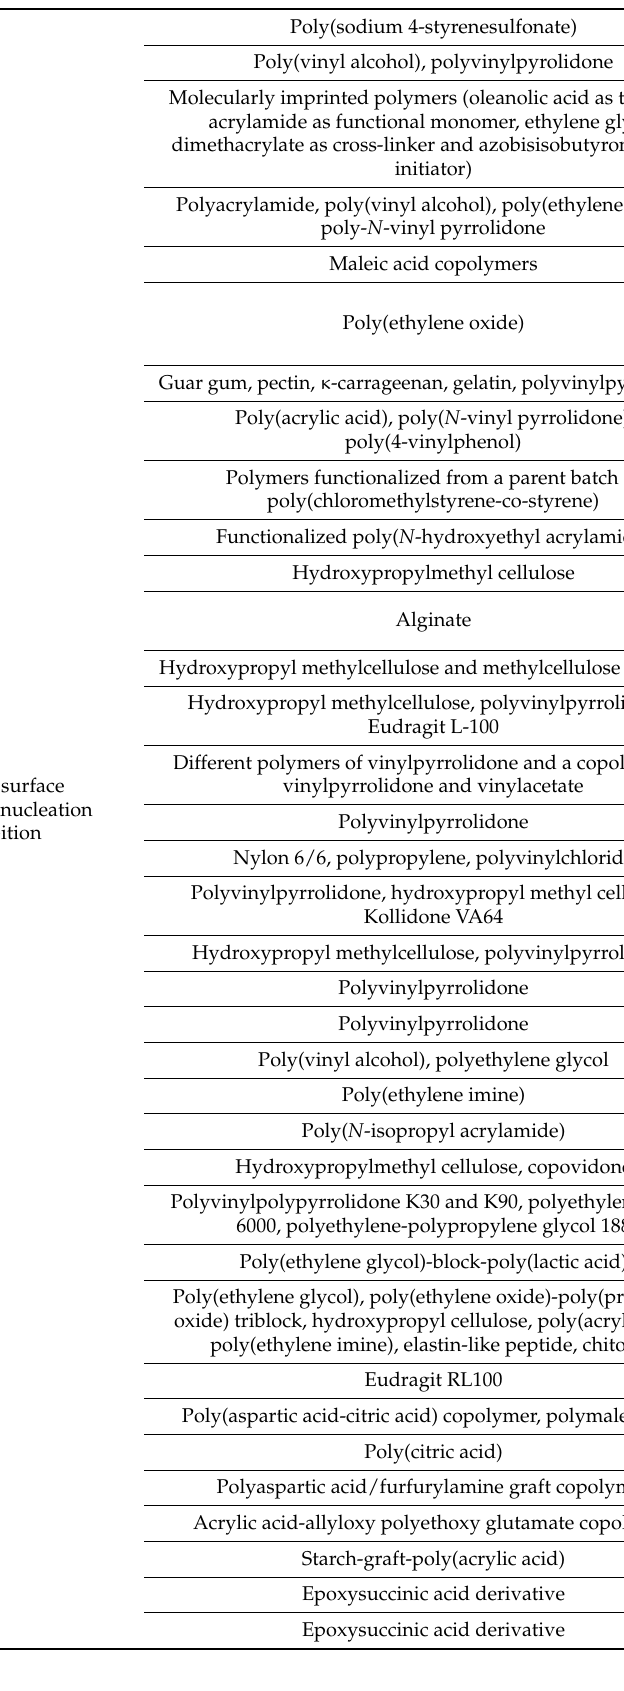
Table 3. Crystal surface screening/nucleation inhibition: Polymers and crystallized substances.